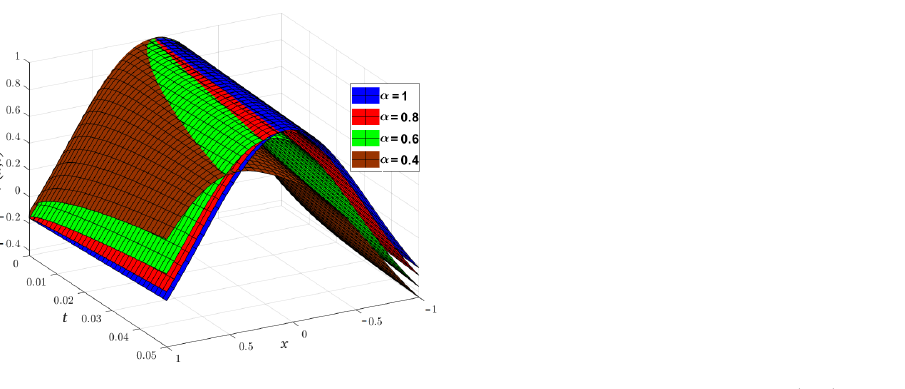
Figure 2. Three-dimensional plots of the approximate and exact solutions of V ( x , t ) (Example 1) using the LADM.